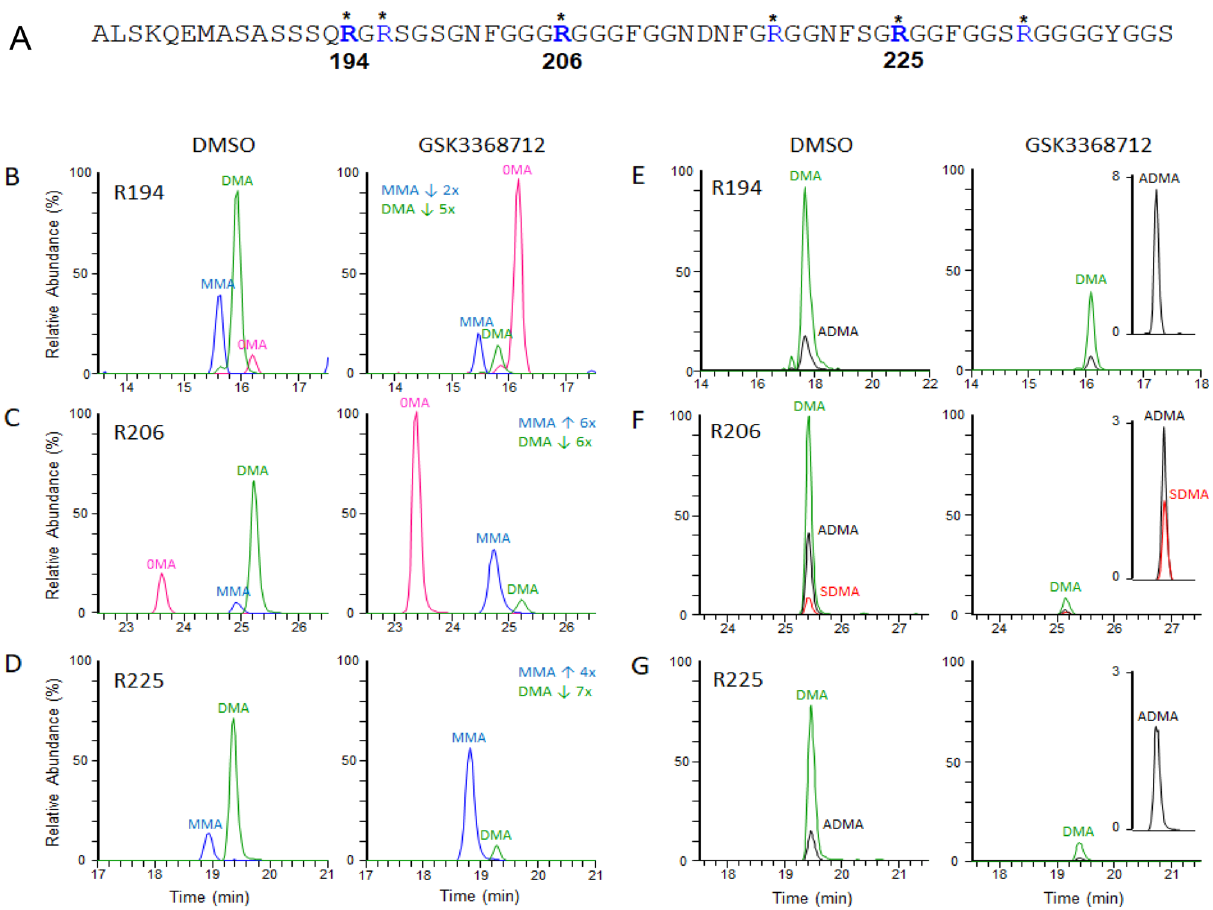
Figure 4. Mass Spectrometry analysis of hnRNP-A1 immunoprecipitated from Toledo cells treated with GSK3368712. (A) Amino acid sequence 180–240 of human hnRNP-A1 (* methylated arginine residues identified by MS). ( B, C and D ) Chromatographic representation of the methylation forms found at arginine residues 194, 206 and R225 and their relative changes induced by treatment with the type I PRMT inhibitor GSK3368712 (2 µM) for 48 h. 0MA, unmethylated arginine. MMA, monomethylated arginine. DMA, dimethylated arginine. ( E, F and G ) Relative levels of asymmetric dimethylarginine (ADMA) and symmetric dimethylarginine (SDMA) with respect to total dimethylarginine 194, 206 and 225 based on generation of diagnostic neutral loss fragment